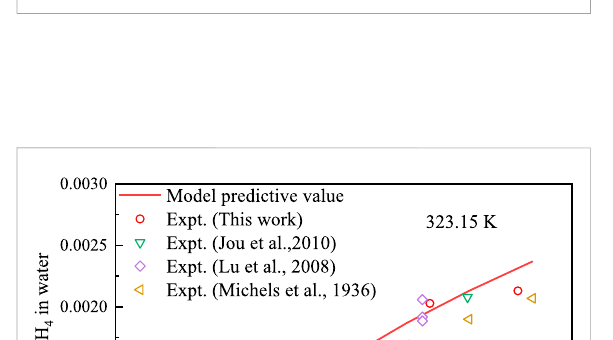
FIGURE 3 Comparison between predicted data of CO 2 solubility model and experimental data at 323.15 K.